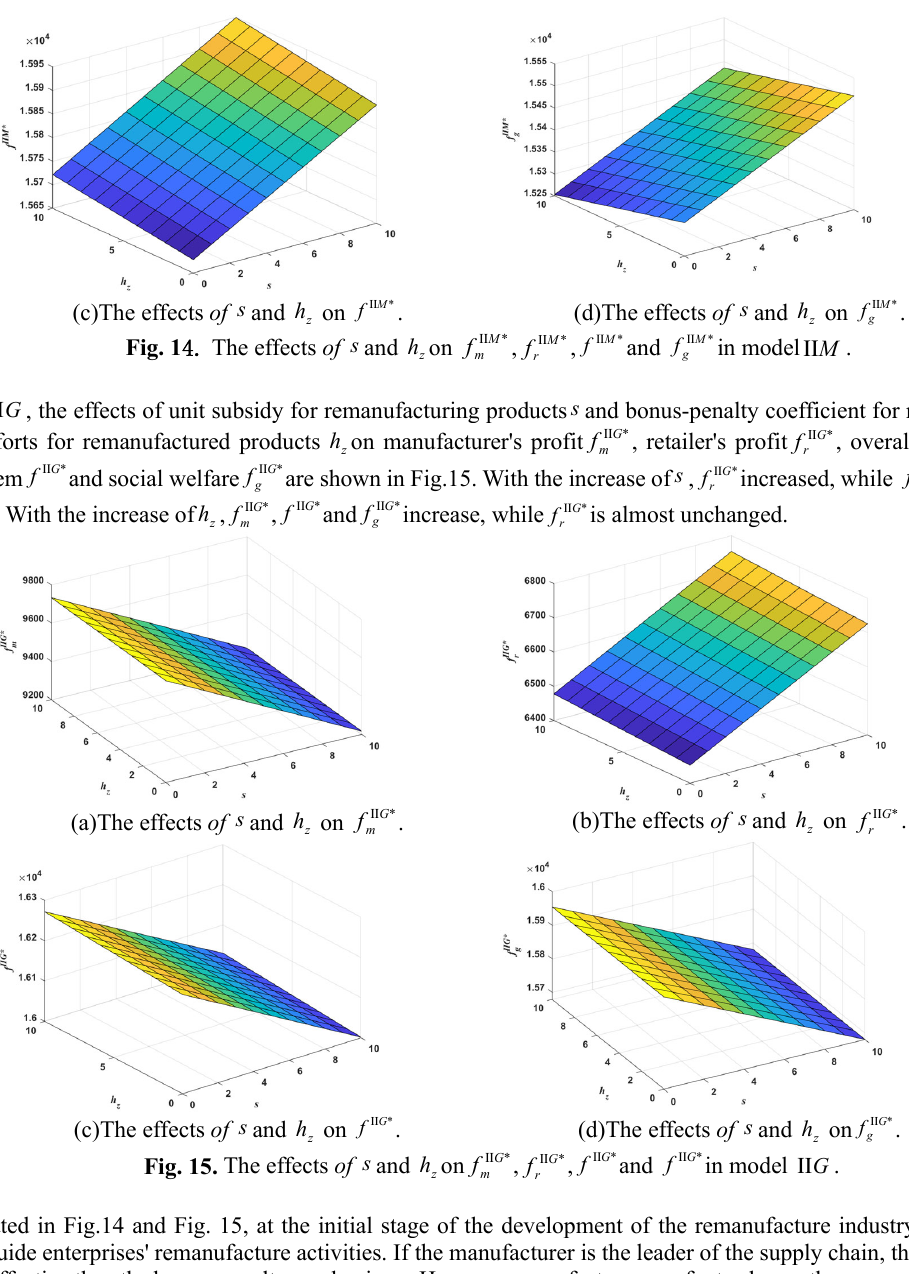
Fig. 15. The effects of s and